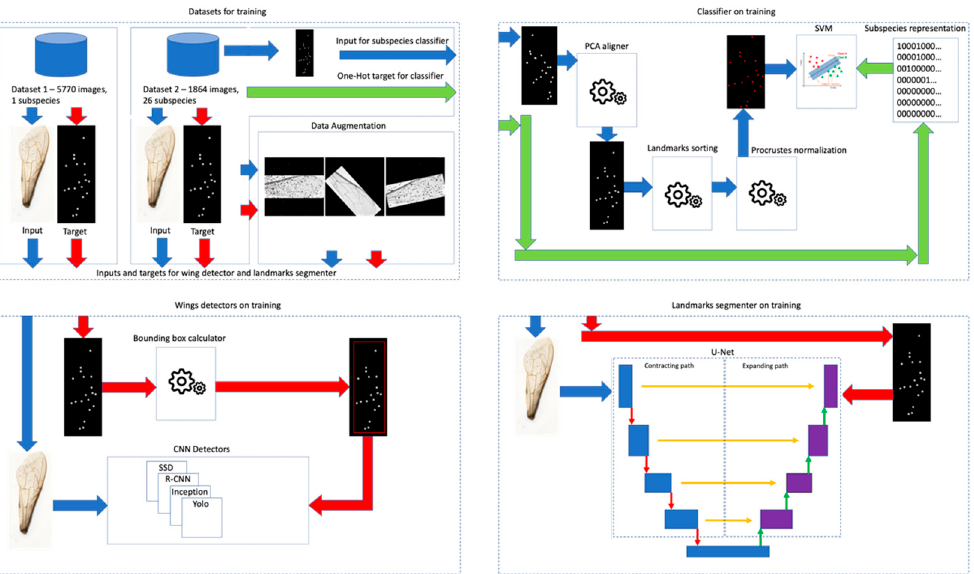
Figure 2. Modeling of the setup to obtain the final solution: the datasets ( top-left frame), the wings detector ( bottom-left frame), the landmarks segmenter ( bottom-right frame), and the subspecies classifier ( top-right frame).